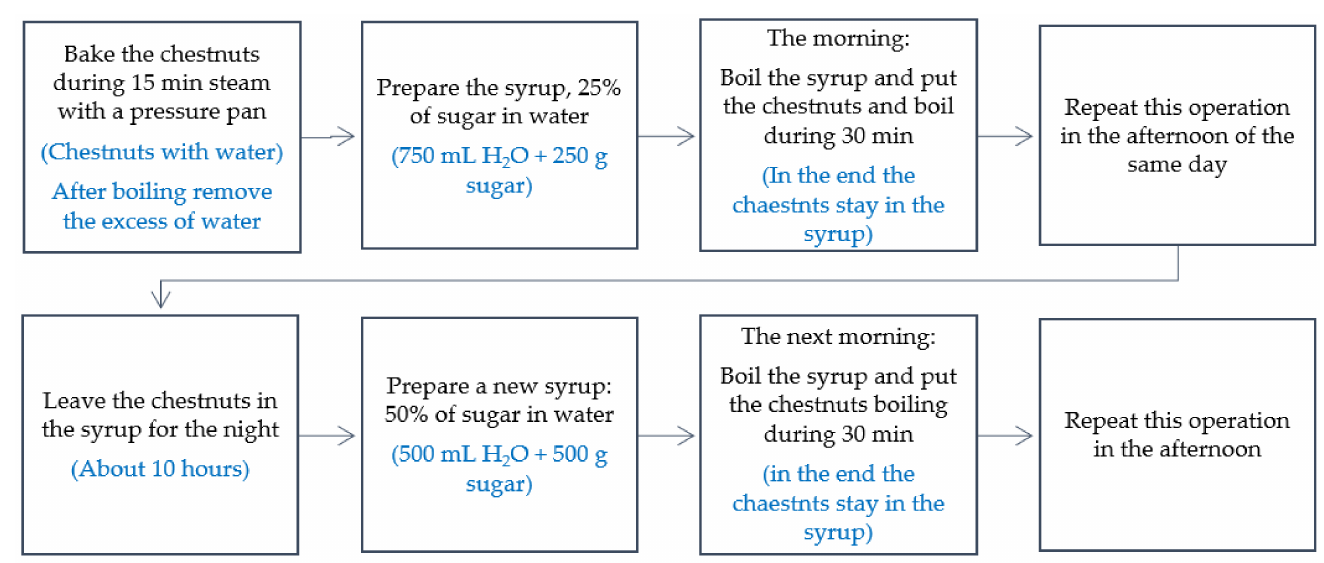
Figure 3. Final recipe for the production of candied chestnuts.